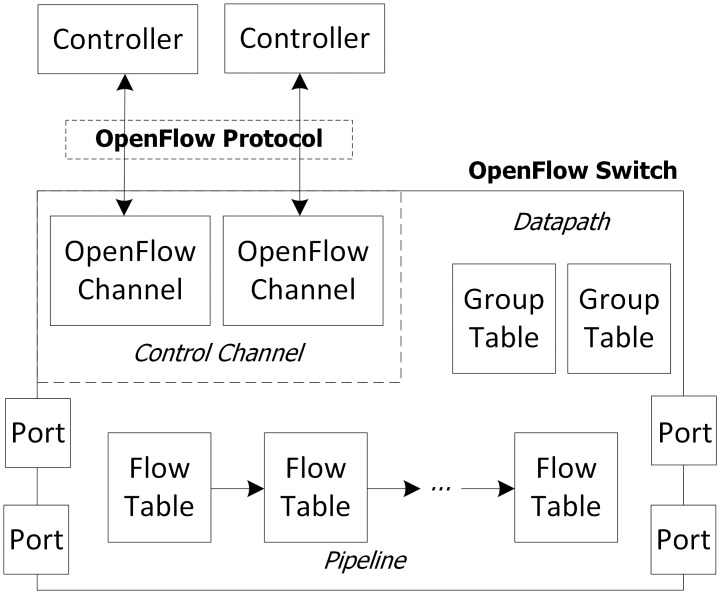
OpenFlow SDN model [36].